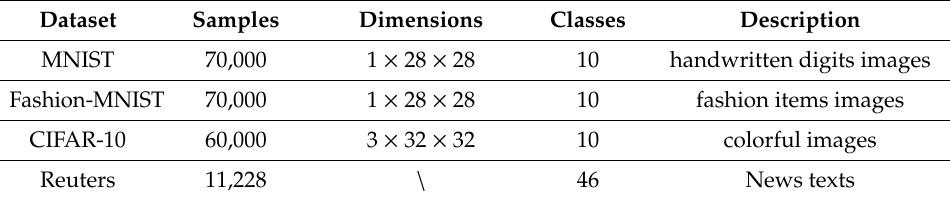
Table 1. Public Dataset